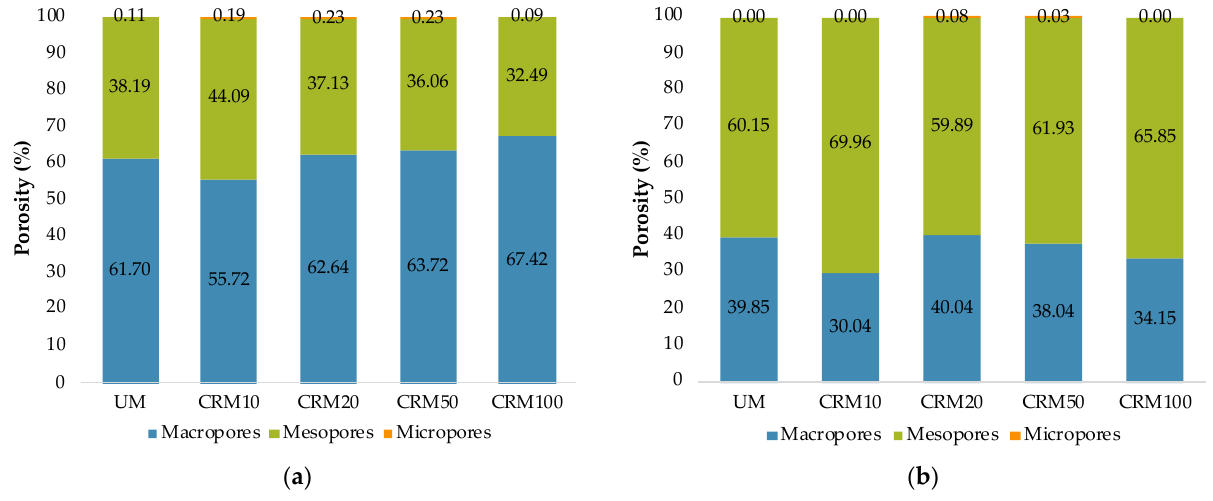
Figure 8. Pore size distribution according to IUPAC: ( a ) adsorption phase; ( b ) desorption phase.